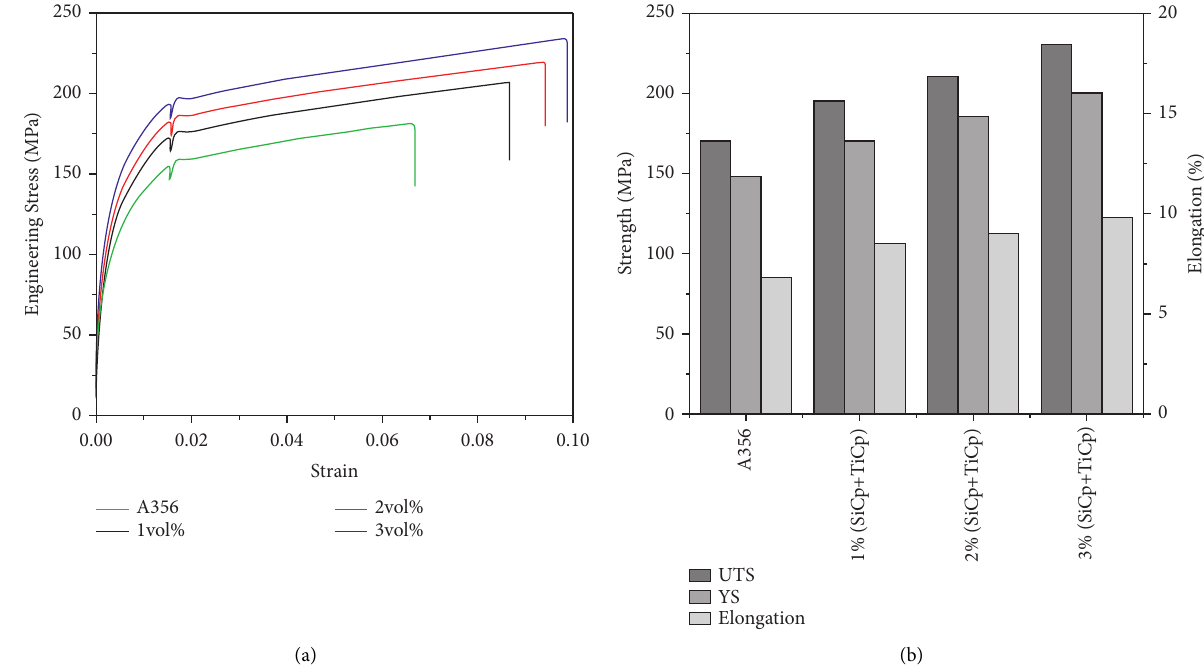
Figure 8: Engineering strain-stress curves and tensile properties of hybrid nano-(SiCp +TiCp)/Al composites: (a) engineering strain-stress curves; (b) UTS, YS, and